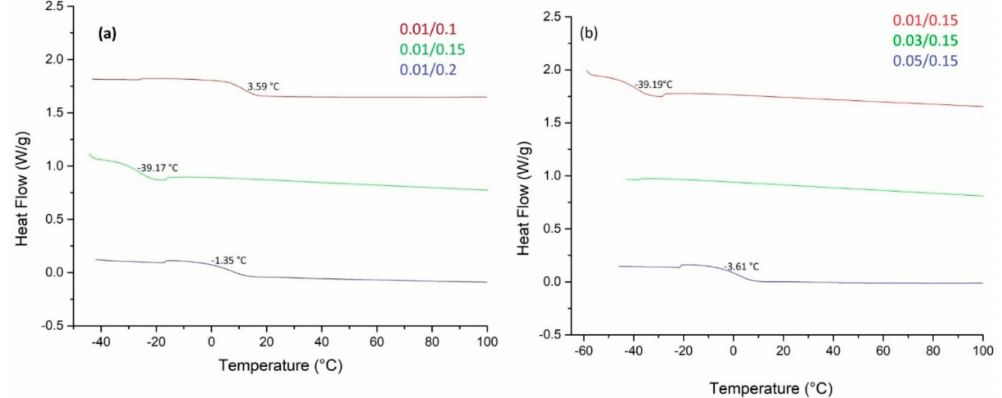
Figure 5. DSC thermograms of PLLA- co -PPGDE, monomer ratio 80/20 wt % with different cat/ini ratio. ( a ) Variation of 1-dodecanol. ( b ) Variation of Sn(Oct) 2 .